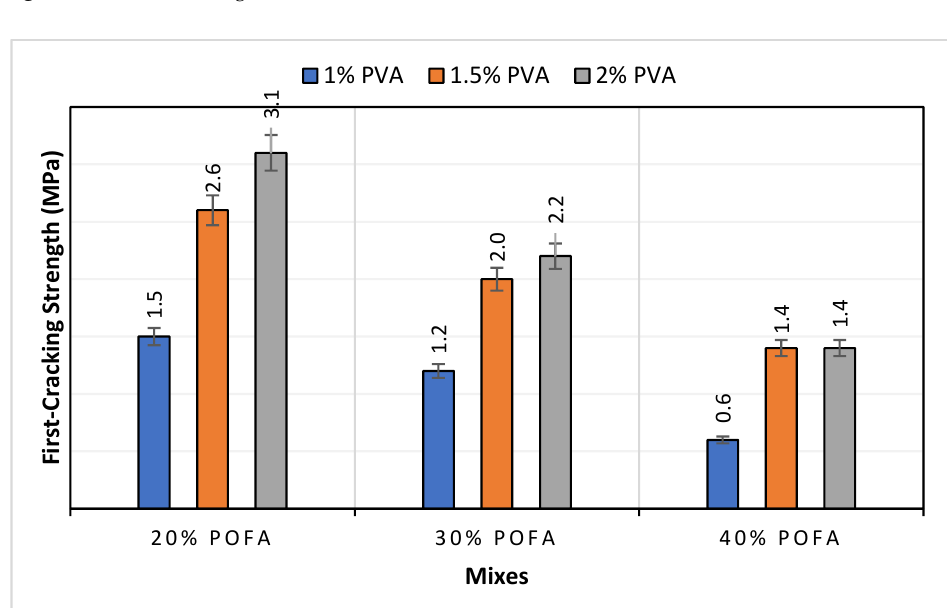
Figure 10. First-cracking strength of POFA mixes.